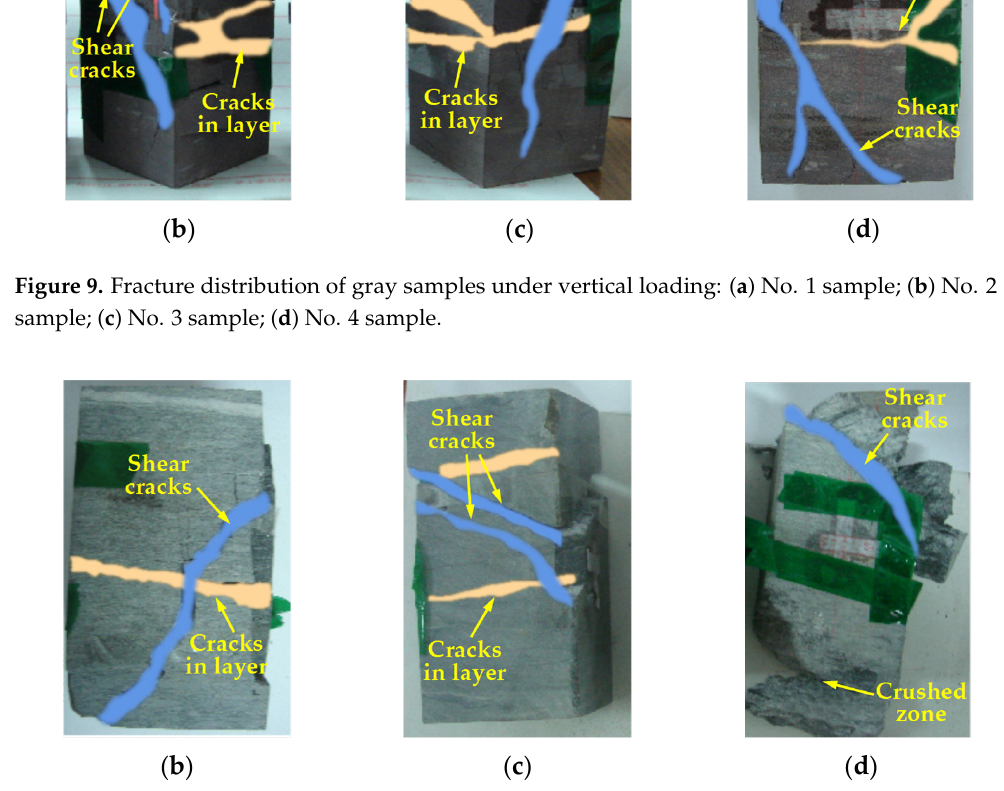
Figure 10. Fracture distribution of carbonaceous samples under vertical loading: ( a ) No. 1 sample; ( b ) No. 2 sample; ( c ) No. 3 sample; ( d ) No. 4 sample.